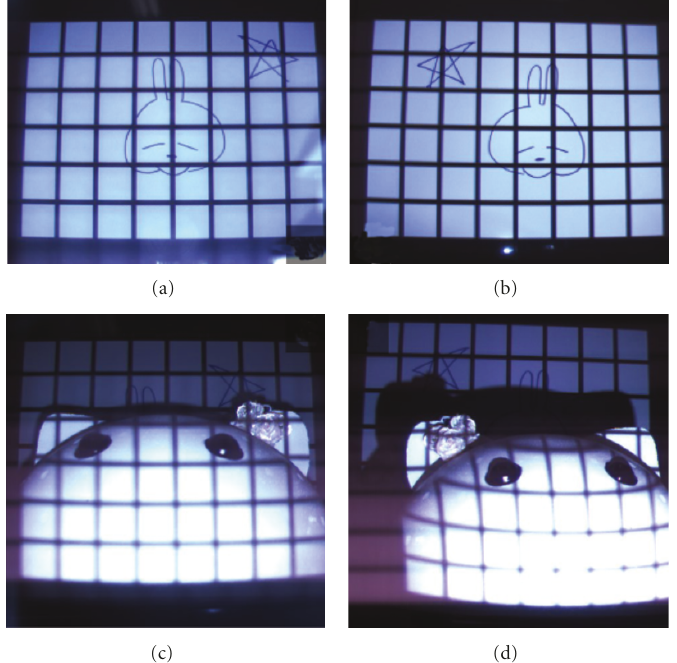
Figure 4: Comparison between the noncolocated (b, d) and colocated (a, c) pro-cam devices. (a, b) show comparisons on a planar surface. (c, d) show comparisons on a curved